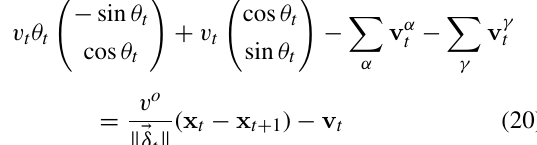
Fig. 5. Vehicle displacement